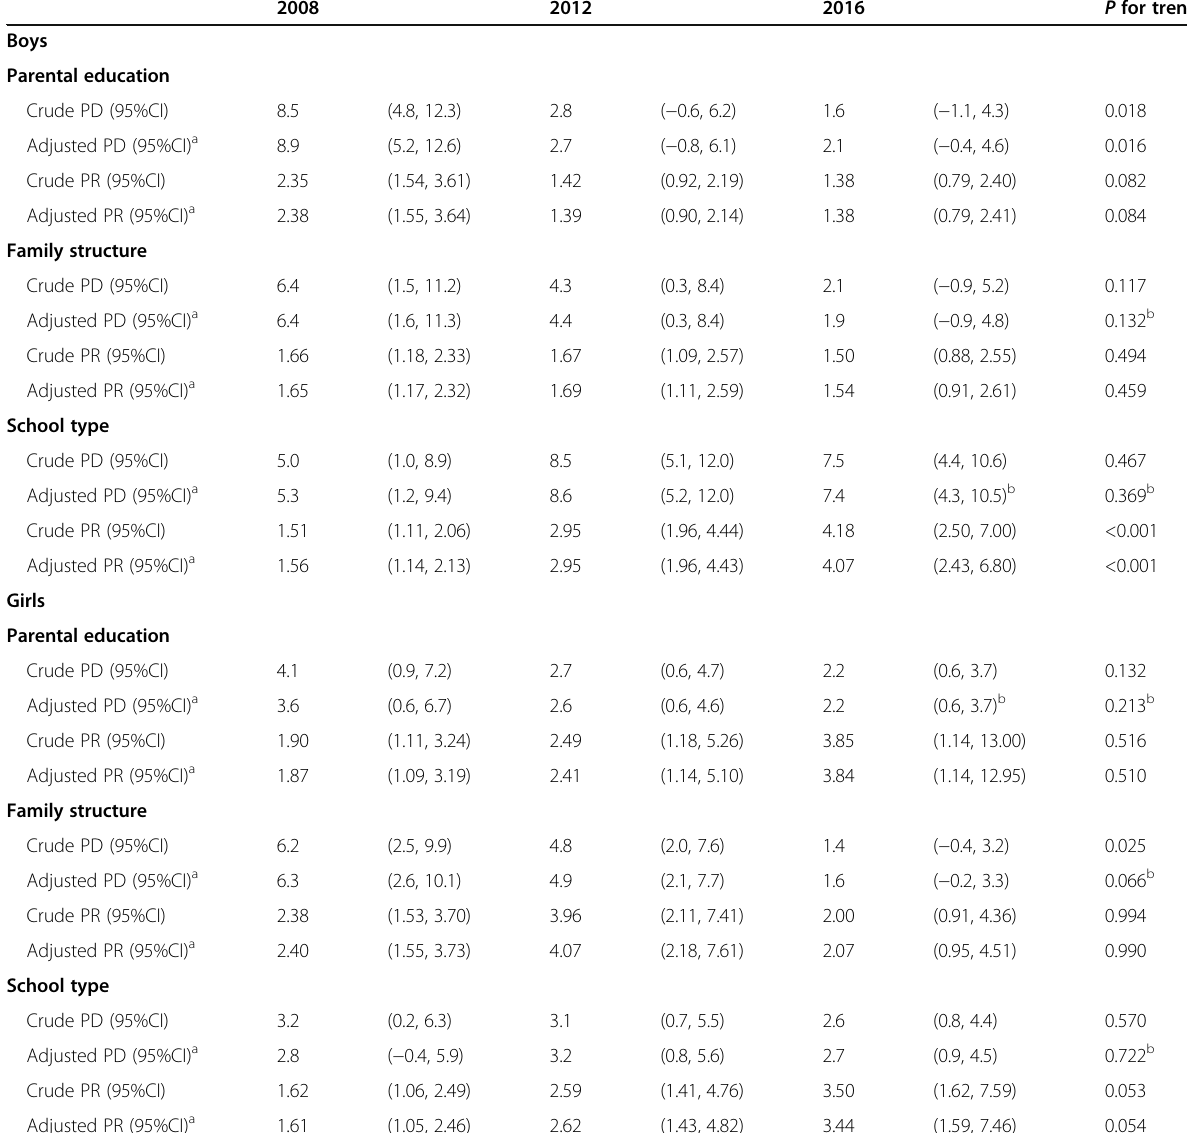
Table 3 Prevalence differences and ratios in current smoking according to the SES indicators by survey year and sex 2008 2012 2016 P for trend